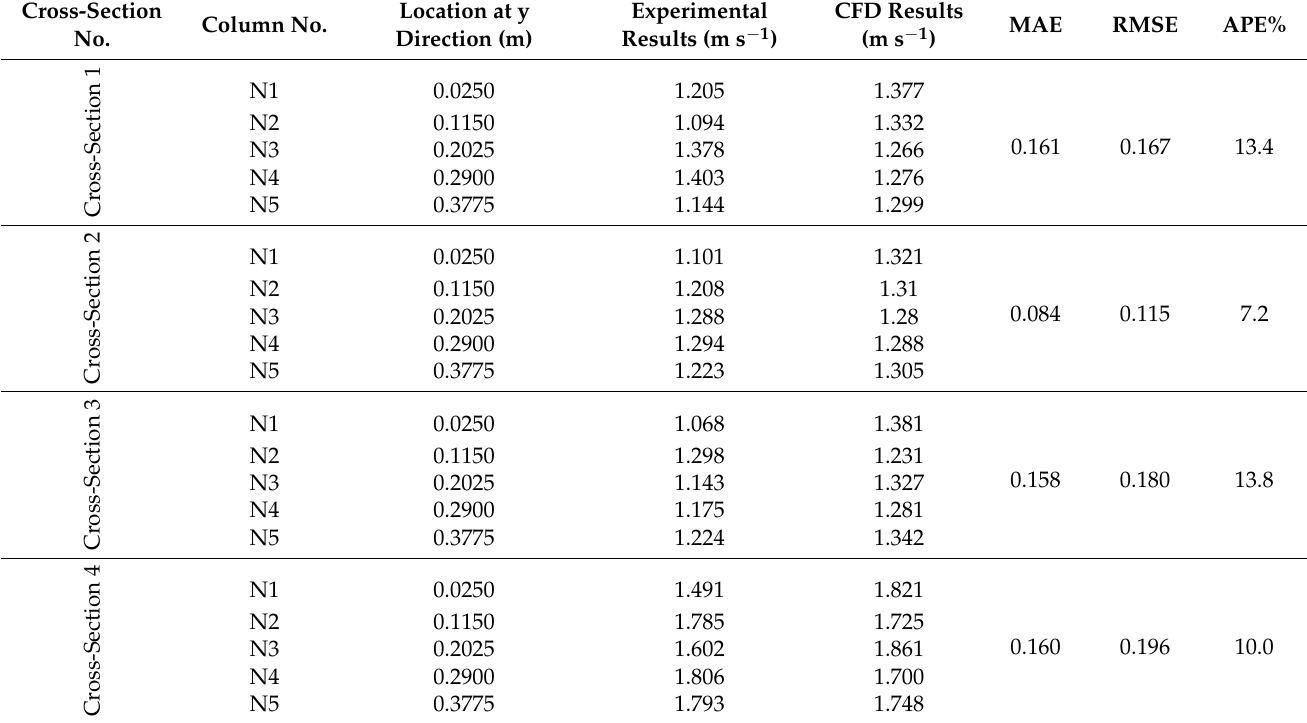
Table 4. Comparison of experiment and CFD velocity values.